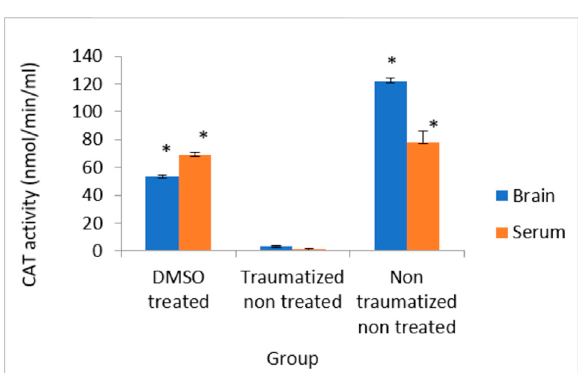
FIGURE 9 Effects of DMSO on the Activity of serum and brain